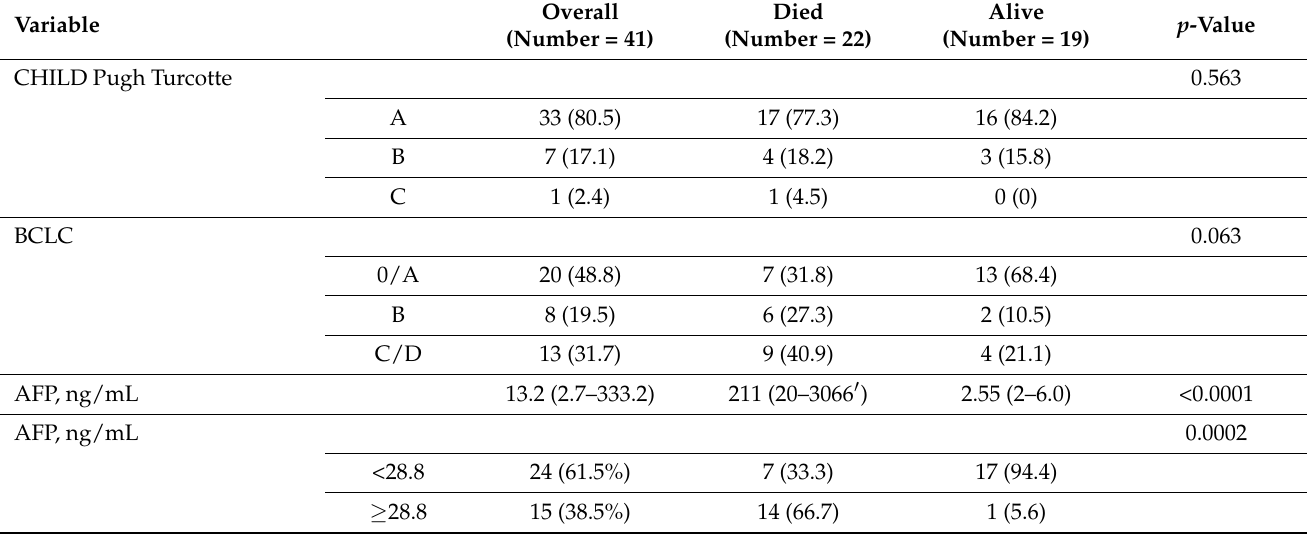
Table 3. Characteristics of PLWH with HCC at last available evaluation according to the primary study outcome (died or